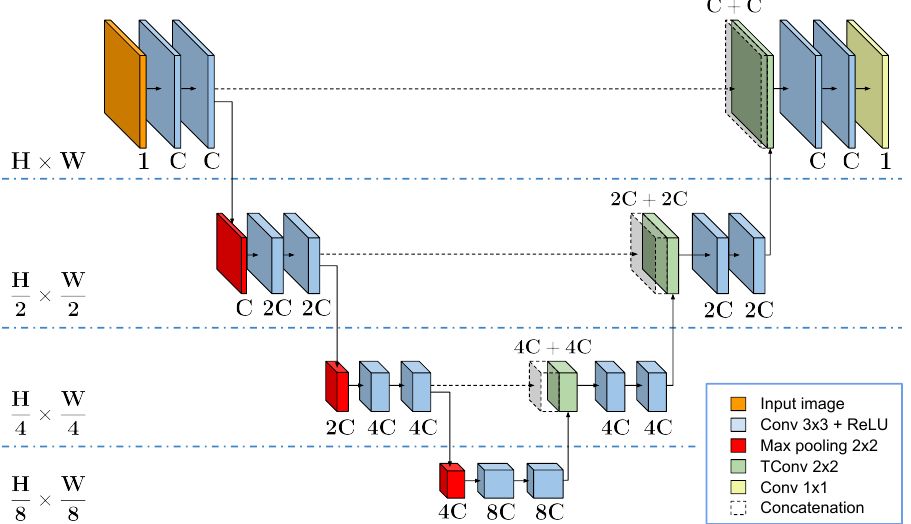
Figure 4. Adopted architecture. The network takes a single-channel image as input and produces, through stacked convolutional blocks, a single-channel prediction. Each of the four encoding levels extracts features at different scales, which are then concatenated to the corresponding decoding features through the system of